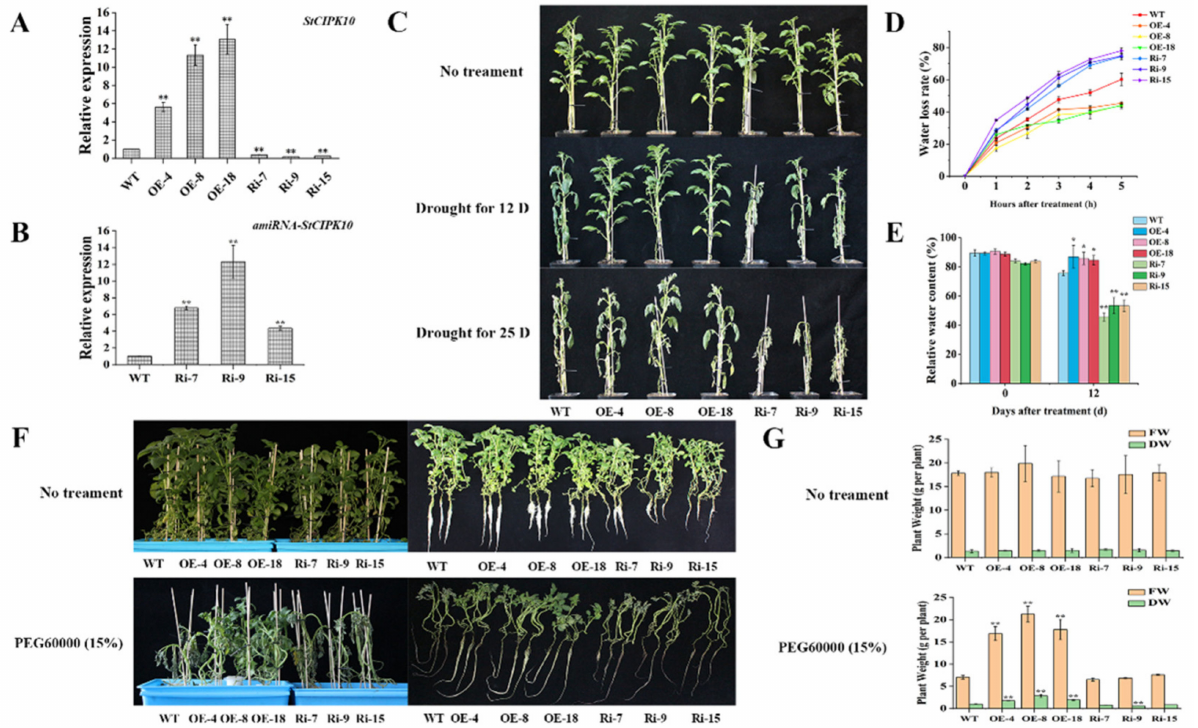
Figure 4. StCIPK10 positively modulates responses to drought and osmotic stress in potato. ( A ) Transcript levels of StCIPK10 in transgenic and WT potato plants. ( B ) Transcript levels of amiRNA- StCIPK10 in RNAi and WT plants. ( C ) Drought tolerance phenotypes of transgenic and WT potato plants in pots filled with soil: vermiculite mixture (3:1) after 12 d and 25 d of withholding water. ( D ) Water loss rates of transgenic and WT potato plants over 5 h. ( E ) RWC of transgenic and WT potato plants after 12 d of withholding water. ( F ) Phenotypes of transgenic and WT potato plants incubated in half-Hoagland solution without stress or with 15% PEG6000. ( G ) FW and DW of transgenic and WT potato plants without stress or after 15% PEG6000 treatments. FW, fresh weight; DW, dry weight. Experiments were repeated three times independently. Data are mean ± SD ( n = 3 ). Significance compared with WT was determined using the ANOVA Duncan’s test; p < 0.05, significant (*); p < 0.01, highly significant